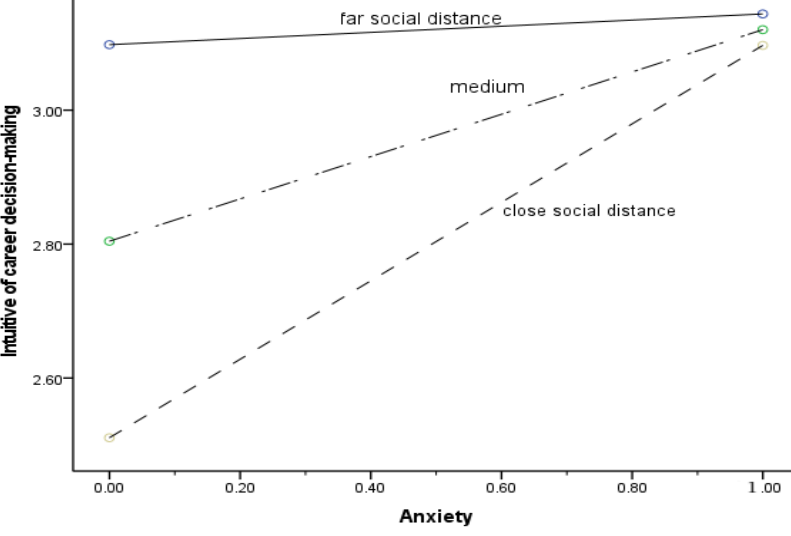
Figure 2. The moderating effect of social distance.